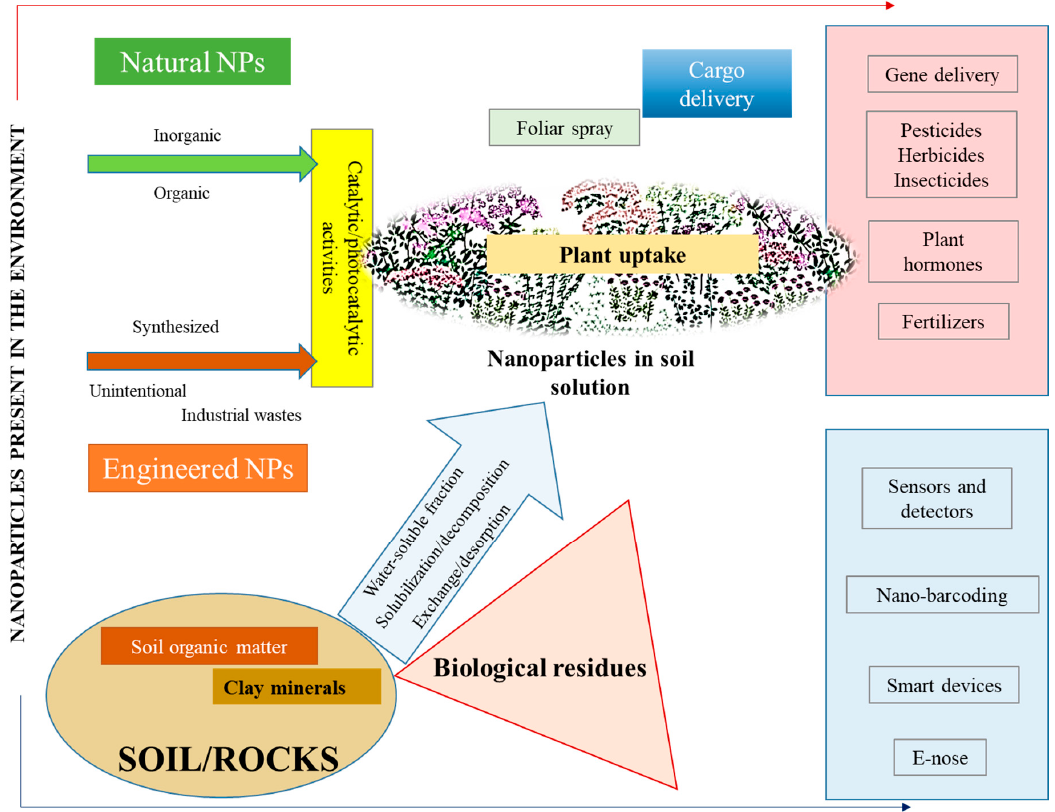
Figure 1. A simplified scheme of the presence and movement of nanoparticles in the environment. Nanoparticles (NPs) get into the environment in a natural way (natural nanoparticles) in the inorganic (volcanic dust, etc.) or possibly organic form (cellular debris), as well as due to human activity (engineered nanoparticles). Such nanoparticles are purposefully synthesized or generated by unwanted processes or as a part of industrial waste. These particles can bind to the soil. From there they are mobilized into the environment as a water fraction, in which they can be solubilized. Thus, the particles can enter the plants through the root system [14] .